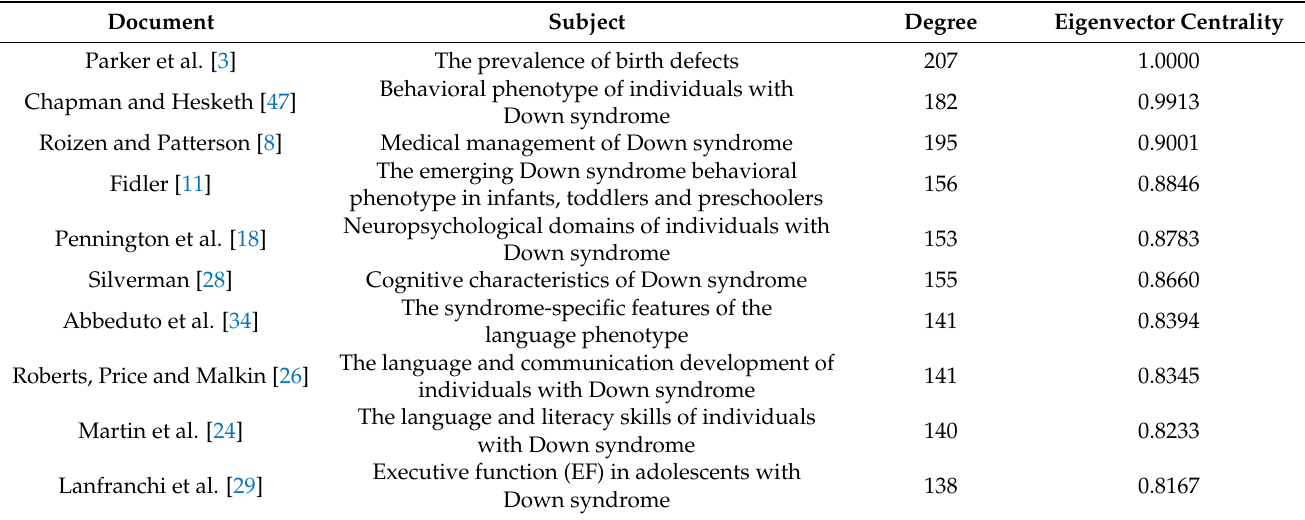
Table 3. Documents with the highest eigenvector centralities in the cited reference network.